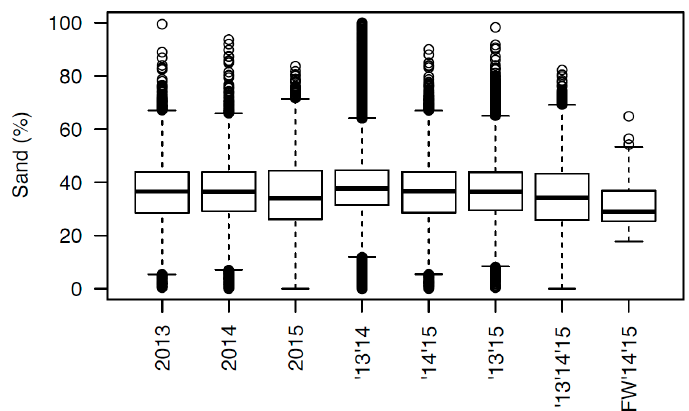
Figure B1. Distribution of the predicted sand percentages for all single images (2013, 2014, and 2015) and the multi-temporal composites (‘13’14, ‘14’15, ‘13’15, and ‘13’14’15) next to the distribution of the sand percentages of the field samples of ’14 and ’15.